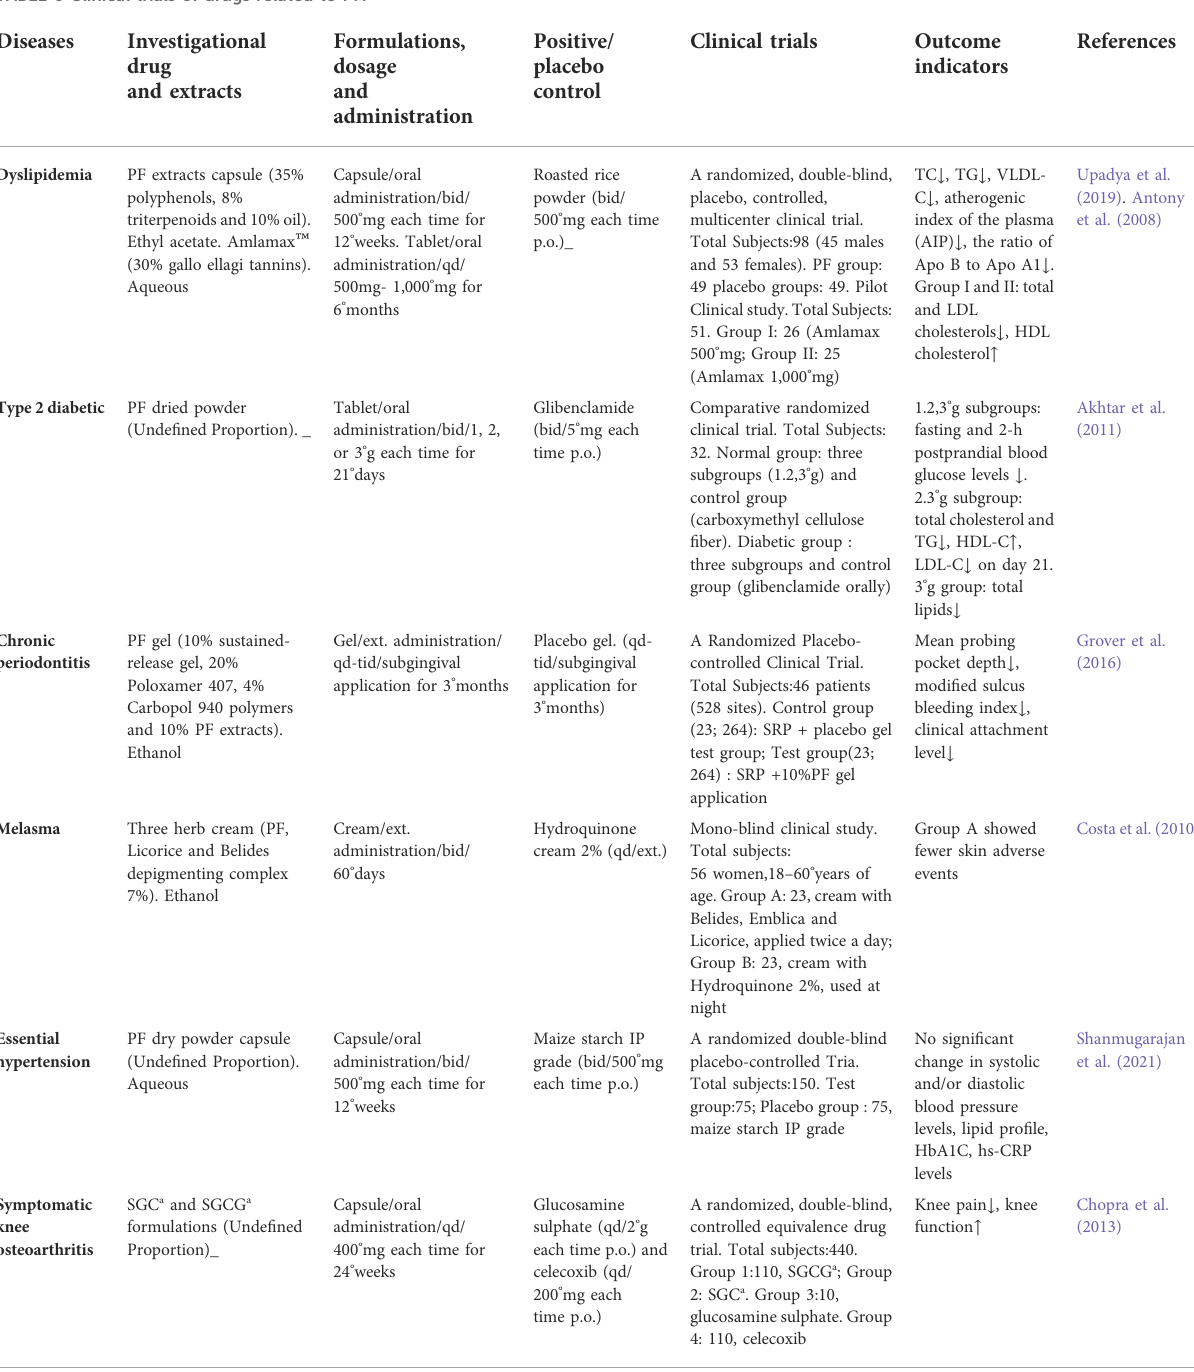
TABLE 6 Clinical trials of drugs related to PF.